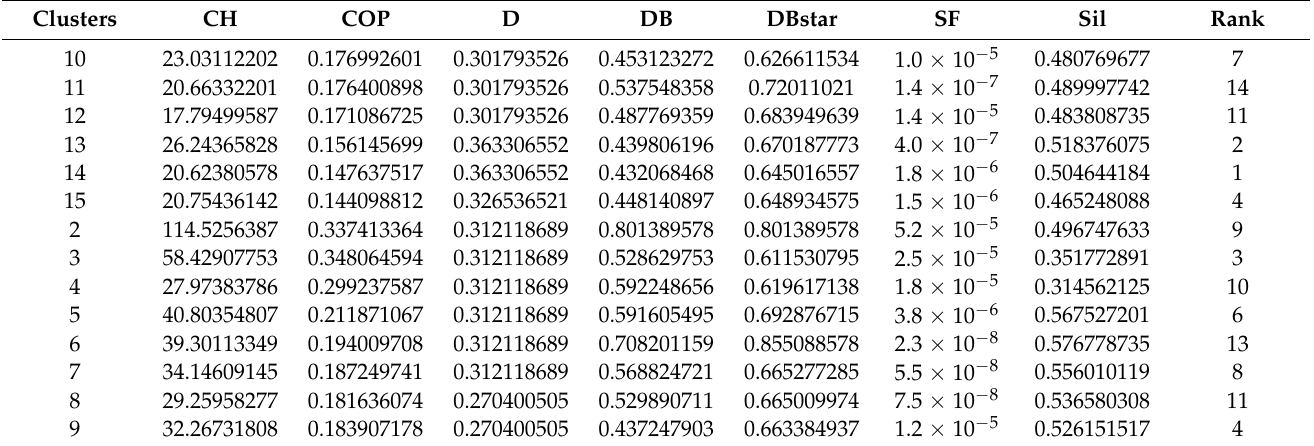
Table 7. CVI results for females aged 20 to 60.